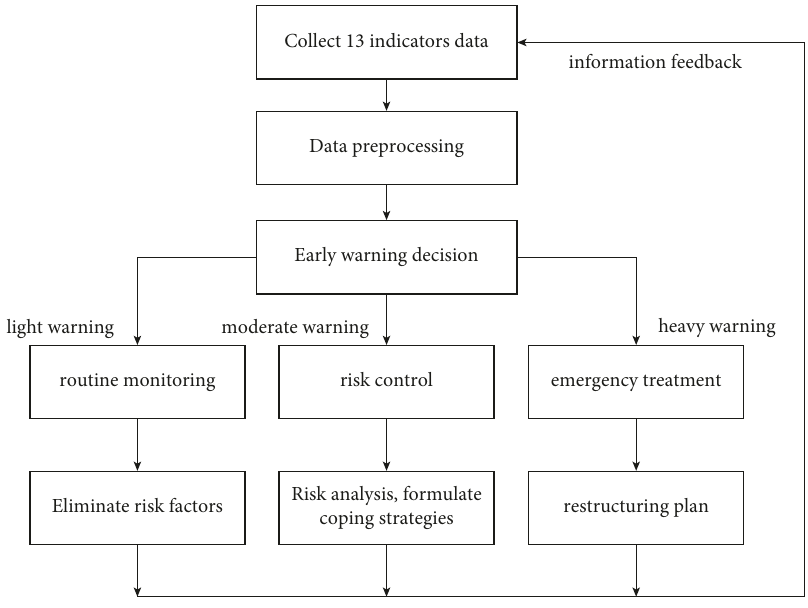
Figure 4: Basic process of food security risk prevention and control.